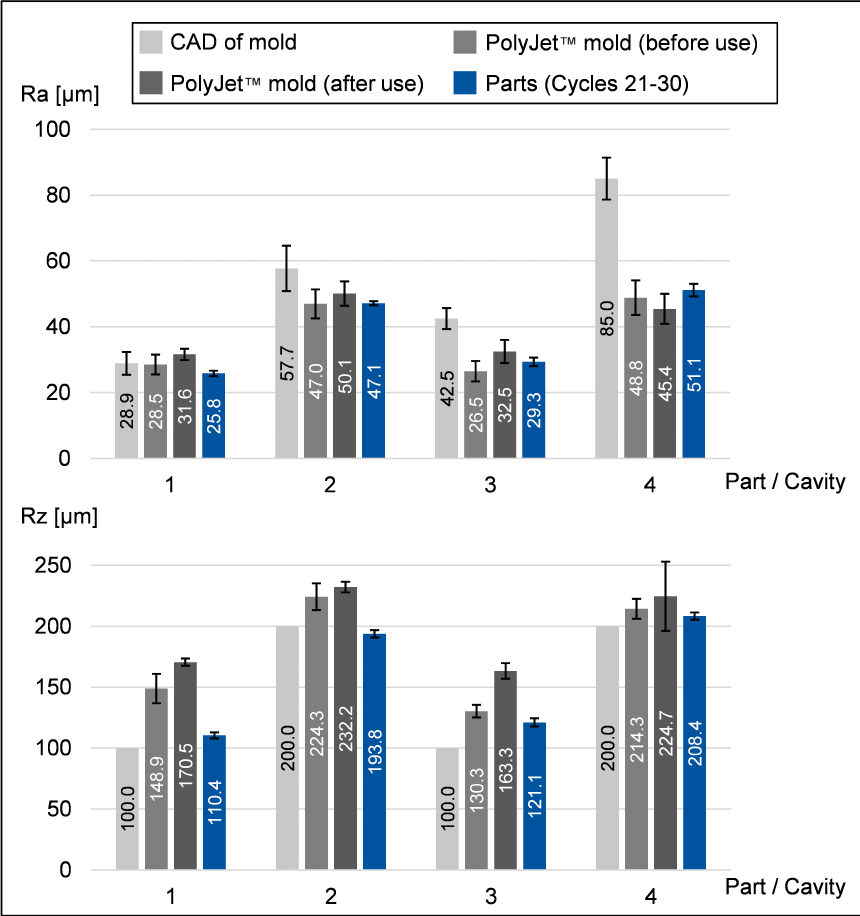
Figure 5. Ra and Rz values of CAD template and PolyJet™